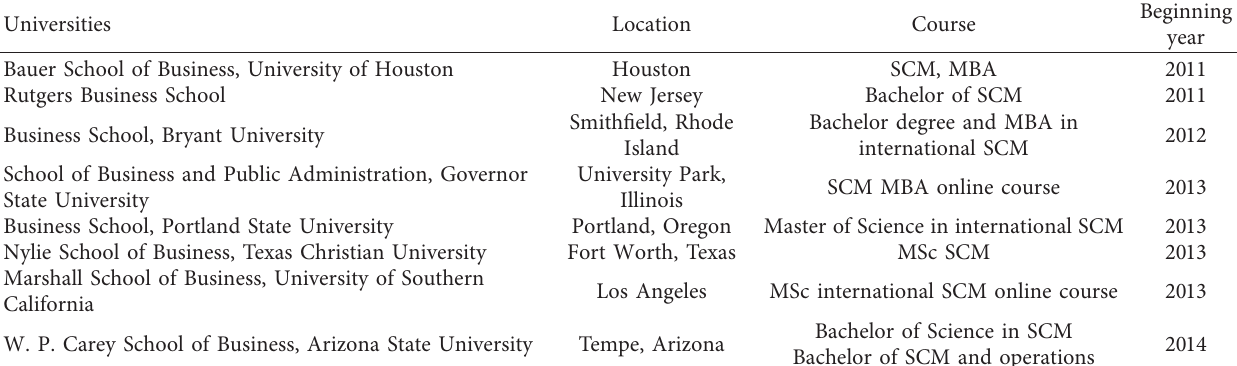
Table 1: New SCM program in some American